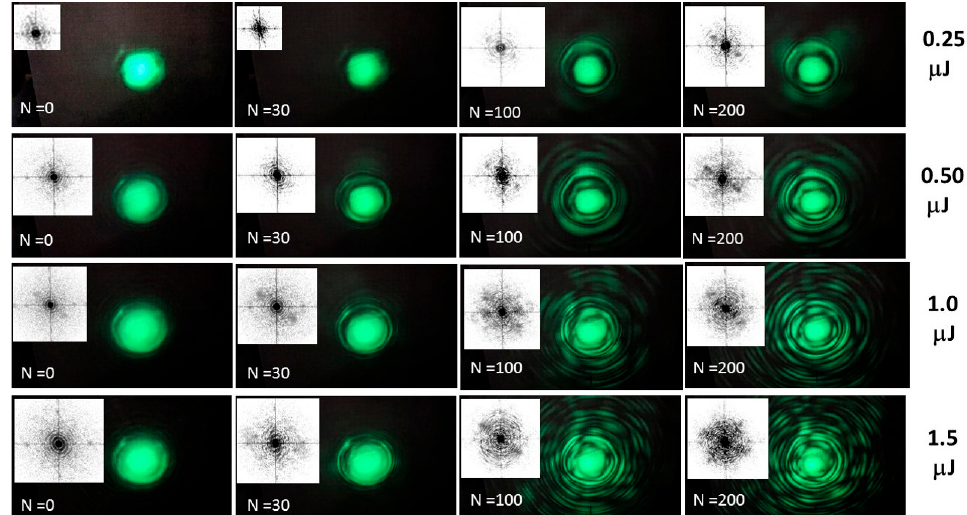
Figure 6. Far-field diffraction patterns of 515 nm, 0.3-ps laser pulses at different energies of 0.25–1.5 µ J (filamentation threshold energy—0.2 µ J) and exposures N = 0–200 (N = 0 corresponds to the first incident laser pulse), and their black/white spatial 2D FFT spectra. The frame size is 17 × 10